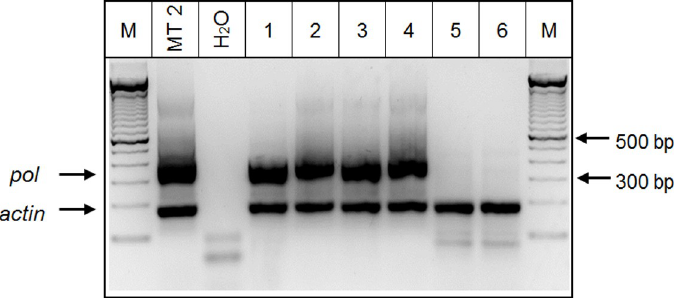
Fig 1. n-PCR with pol HTLV-1/actin co-amplification. MT2 (positive control), H 2 O (negative control), line 1: HAM/ TSP sample, 2: ATLL sample, 3: HAM/TSP sample, 4: HTLV-1 asymptomatic sample, 5 and 6 samples from healthy blood donors. The arrows point to the bands of pol and actin amplification and 100 bp DNA Ladder (M).